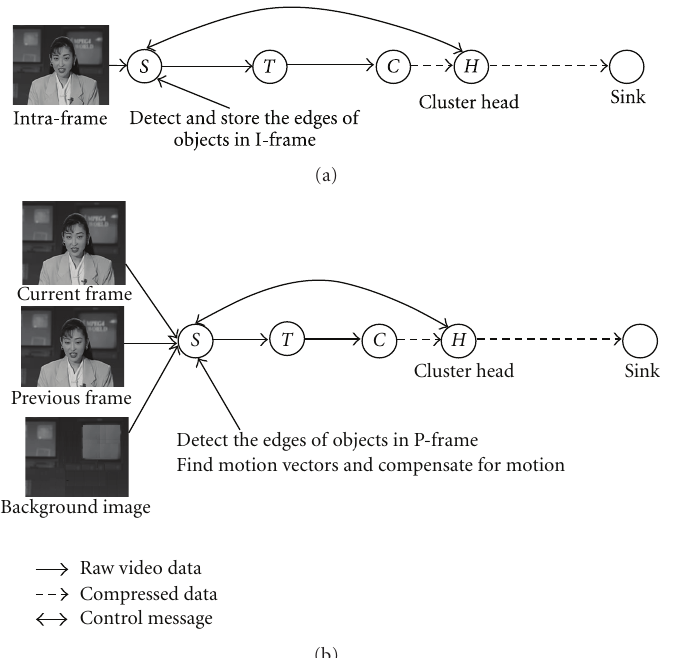
Figure 8: The normal case of the proposed video compression scheme 1 with N hops = 3 for (a) I-frames and (b)